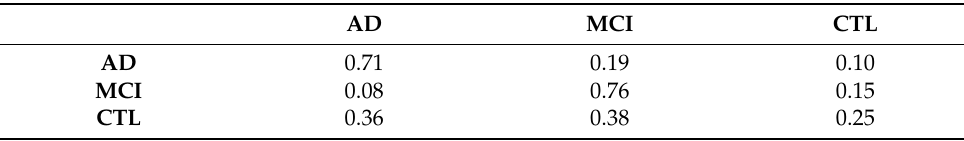
Table 4. Confusion matrix for three-class